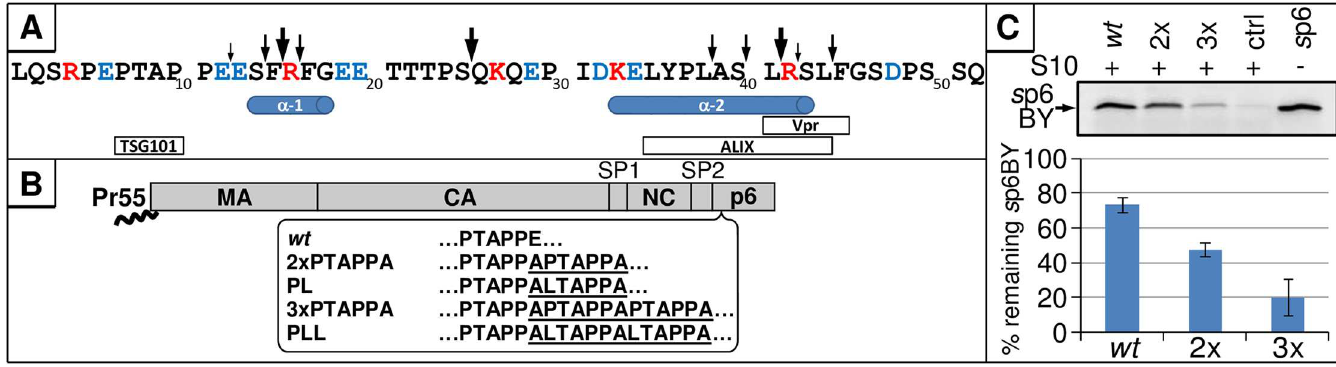
Fig 8. Generation of stable p6 mutants. (A) 100 ng s p6 were incubatedwith 10 ng rIDE for 1, 5, 10, 30 or 60 min at 37˚C. Reactions were stoppedby adjustingthe samplesto 0.3% (w/v) TFE and subsequently analyzedby mass spectrometry. Arrows abovethe primary sequencerepresent the detected cleavagesites, and initial and secondary cleavagesites are indicatedas big or small arrows, respectively. Red font indicatespositivelycharged,and blue negatively chargedresidues.Previously identified α -helicesand bindingmotifs are depictedbelowthe primary sequence. (B) p6 mutants that encode multiplePTAPPA- or LTAPPA-motifs were generated.The introducedamino acids are underlined. (C) 10 ng of s p6BY were incubatedwith 250 μ g/ml s p6 wt , 2xPTAPPA, 3xPTAPPA or only buffer and 5 μ g S10 for 30 min at 37˚C. s p6BY was detected by fluorescence emissionand quantified.Values represent the arithmetic mean ± SD of four